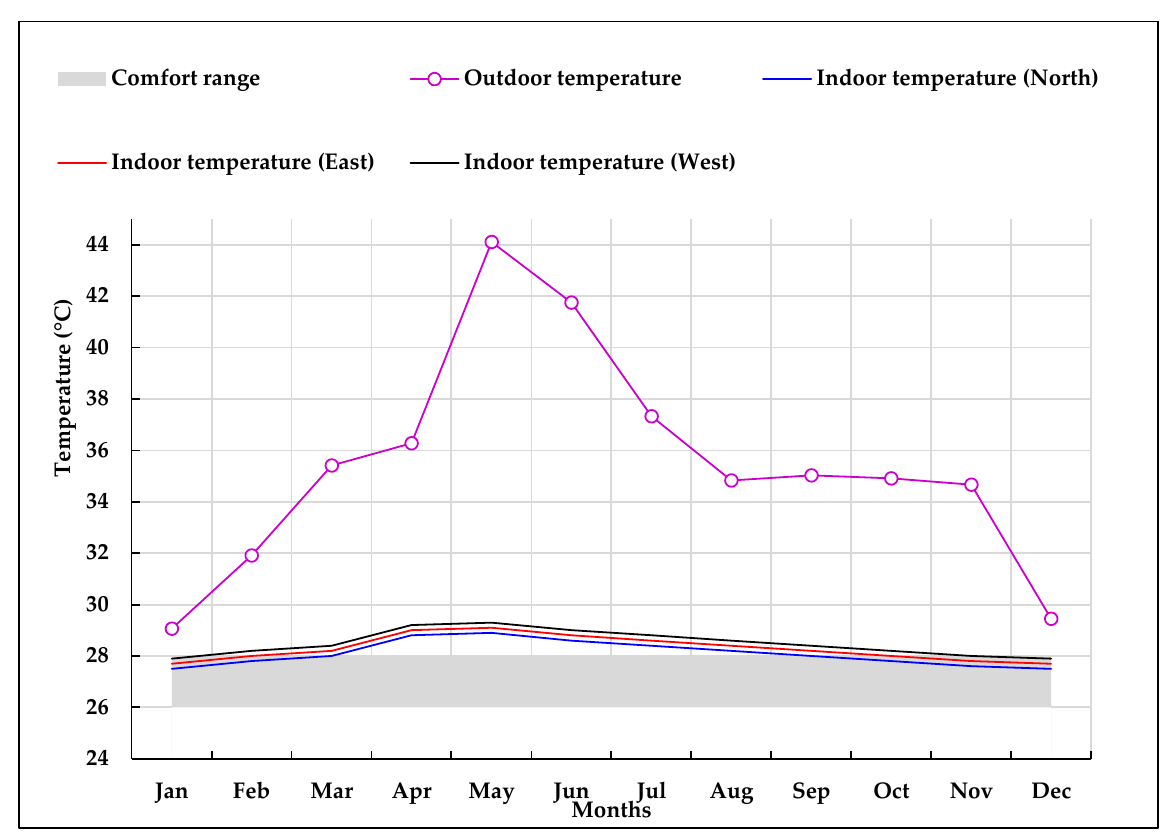
Figure 9. The average monthly indoor temperature in each wing after EAHE installation. Table 8. The average monthly reduction in energy demand, indoor temperature, and airflow in each wing of the ACB after interventions.